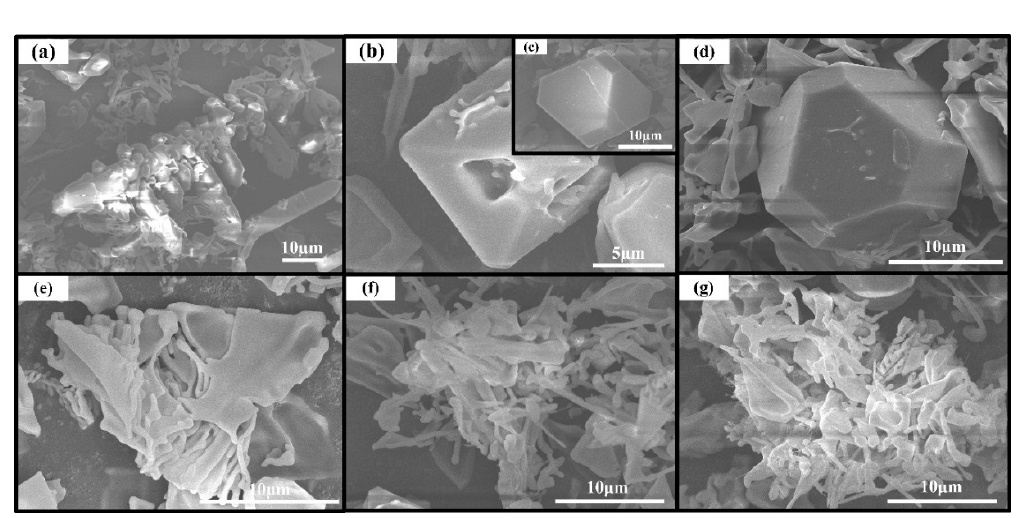
Figure 7. FESEM images of primary and eutectic Mg 2 Si extracted from Al–20Mg 2 Si alloys without and with various Li and Sb additions: primary Mg 2 Si in ( a ) 0; ( b )–( c ) 0.2; ( d ) 0.5 wt.% Li ‐ Sb; and eutectic Mg 2 Si in ( e ) 0; ( f ) 0.2; and ( g ) 0.5 wt.% Li ‐